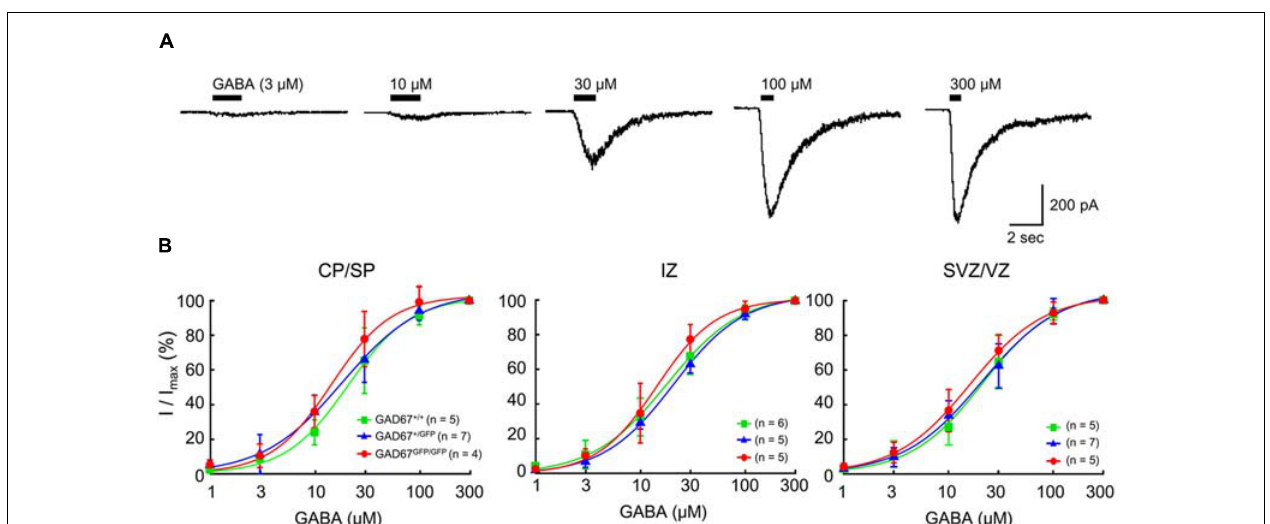
FIGURE 2 |The sensitivity of GABA A Rs to GABA in RFP-positive cells in the E17.5 cerebral cortex does not differ between wild-type and GAD67-GFP knock-in mice. (A) Representative GABA-evoked currents recorded in an RFP-positive cell from a GAD67 + / + fetus.The holding potential ( V H ) was − 60 mV.The puff application of GABA was stopped immediately after desensitization was initiated. (B) Dose–response curves of GABA currents.The EC 50 s of the current responses in GAD67 + / + , GAD67 + / GFP , and GAD67 GFP / GFP fetuses were 16.23 ± 1.75, 17.46 ± 2.11,